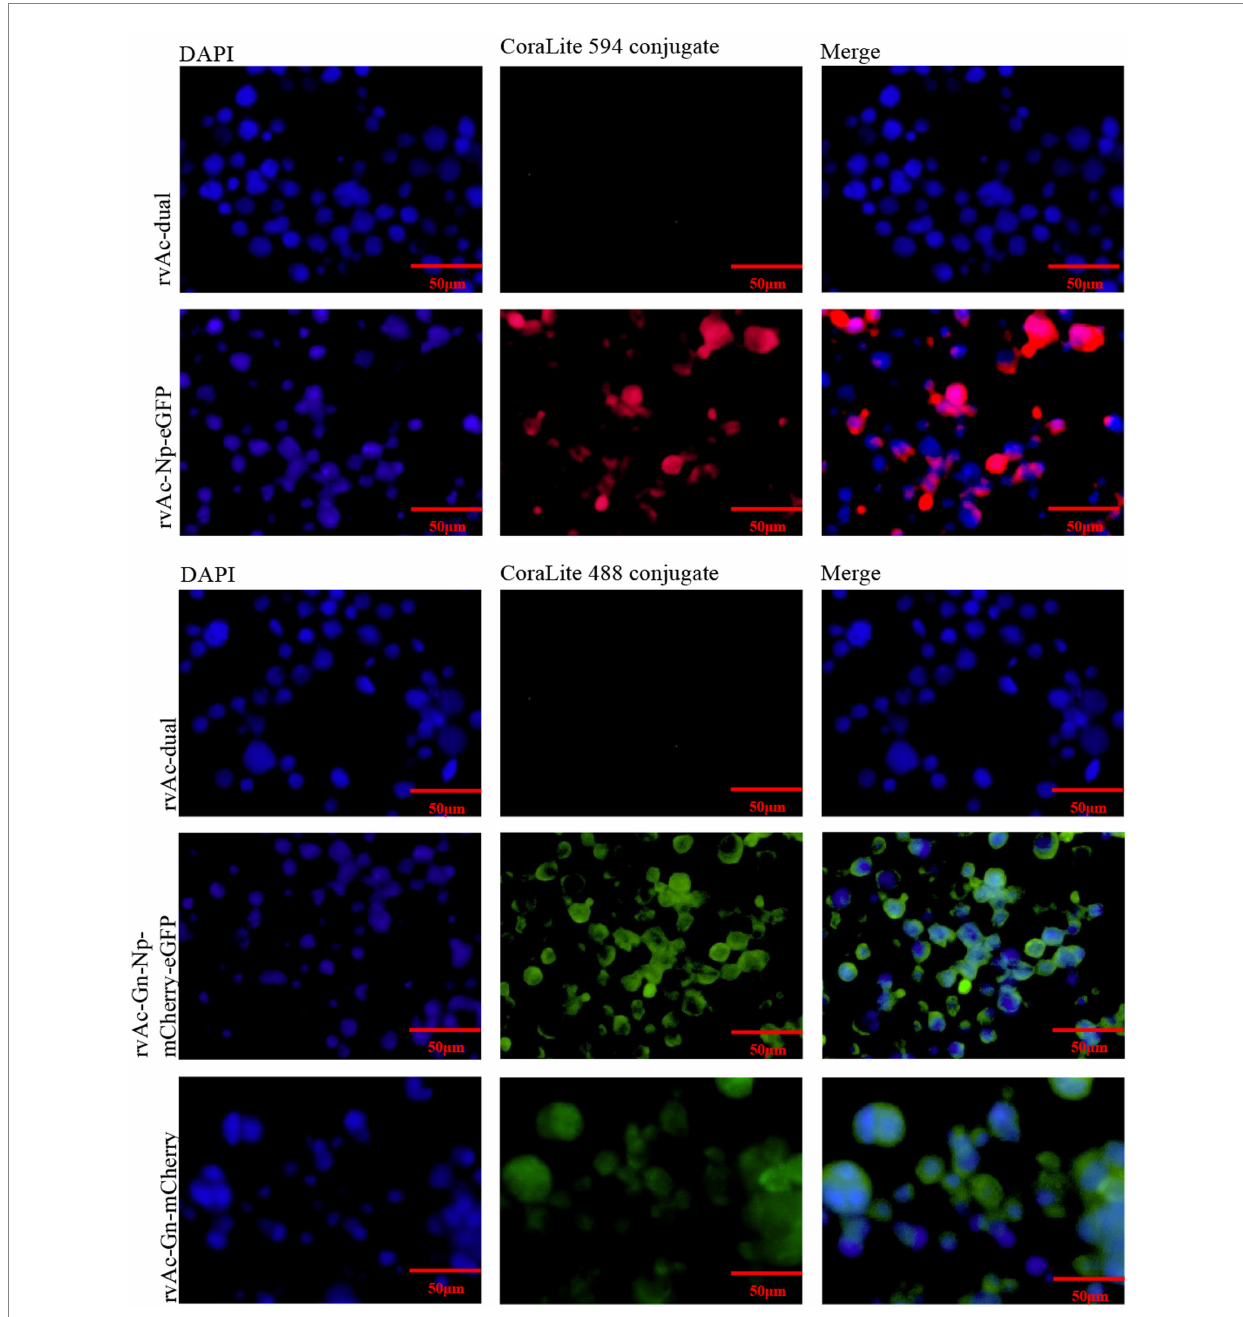
FIGURE 4 Indirect immunofluorescence of recombinant baculovirus- and wild-type virus-infected